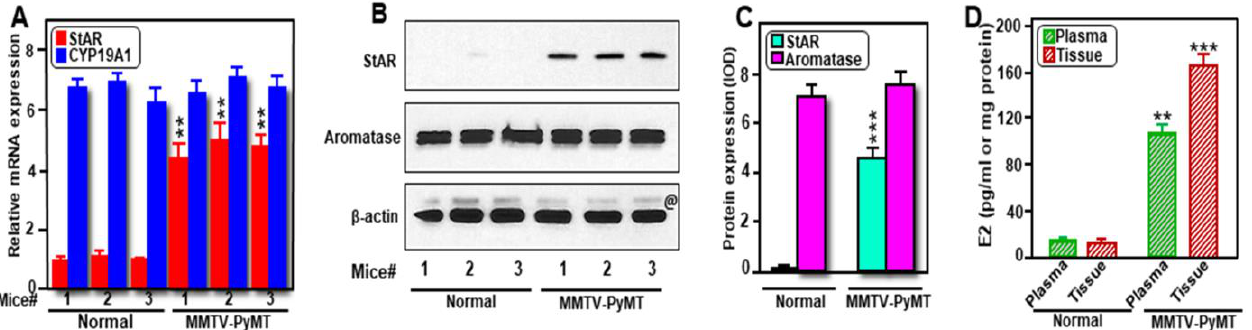
Figure 5. Determination of StAR and aromatase, at mRNA and protein levels, in breast tissues; and E2 levels in plasma and breast tissues from normal and MMTV-PyMT mice. Various breast tissues (3 mice in each group) were subjected to either RNA extraction or whole cell protein preparation, as described under Materials and methods . StAR and CYP19A1 mRNA levels were determined by RT-qPCR and combined data are presented ( A ). Representative immunoblots show expression of StAR and aromatase in three independent mice from each category using 70 µ g of total protein ( B ). β -actin expression was assessed as a loading control. IOD values for StAR and aromatase, in each band, were quantified and normalized with the corresponding β -actin bands, and combined data are presented ( C ). Both breast tumor tissue lysates and plasma from each mouse were extracted with dichloromethane, and E2 levels were determined by ELISA and presented as either pg/mL (plasma) or pg/mg protein (tissue) ( D ). Results represent the mean ± SE of three independent mice. **, p < 0.01; ***, p < 0.001 vs. Normal. @, non-specific band.